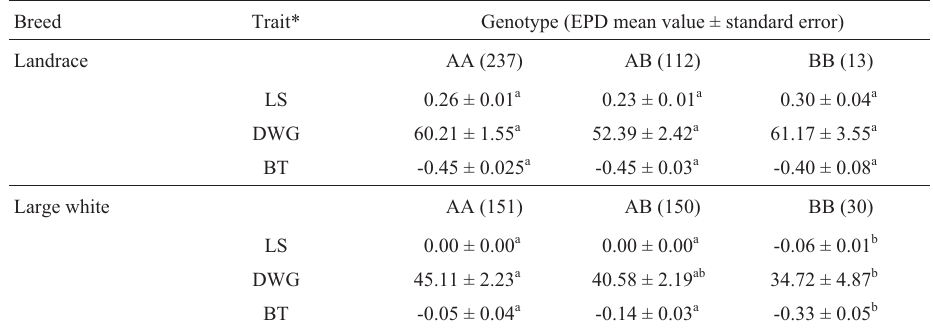
Table 2 - Number of observations, expected progeny difference (EPD) mean and standard deviation values for litter size (LS), daily weight gain (DWG) and back fat thickness (BT) traits in 362 Landrace and 331 Large White breeds genotyped for the estrogen receptor gene.